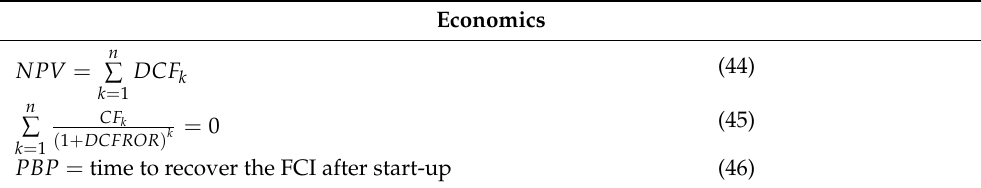
Table 7. Profitability key